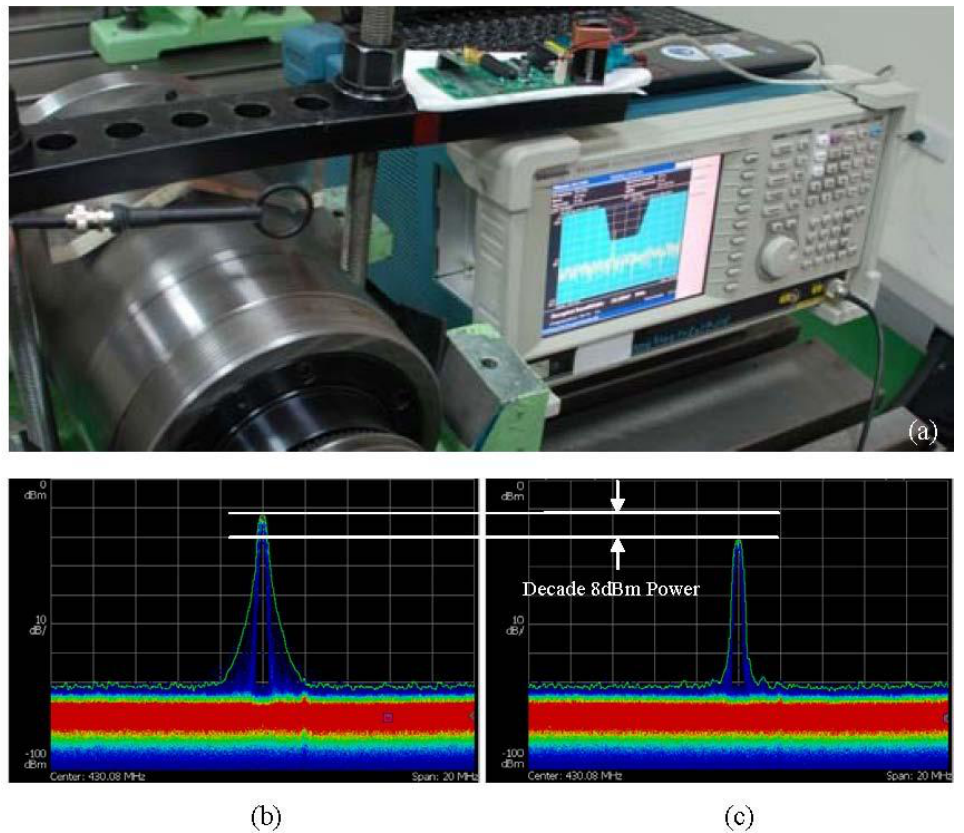
Figure 4. The results of the power attenuation of the signals transmitted through a metal case. ( a ) Architecture of the testing system. ( b ) The results measured at a distance of 20 mm in free space. ( c ) The results measured across a 20 mm thick metal